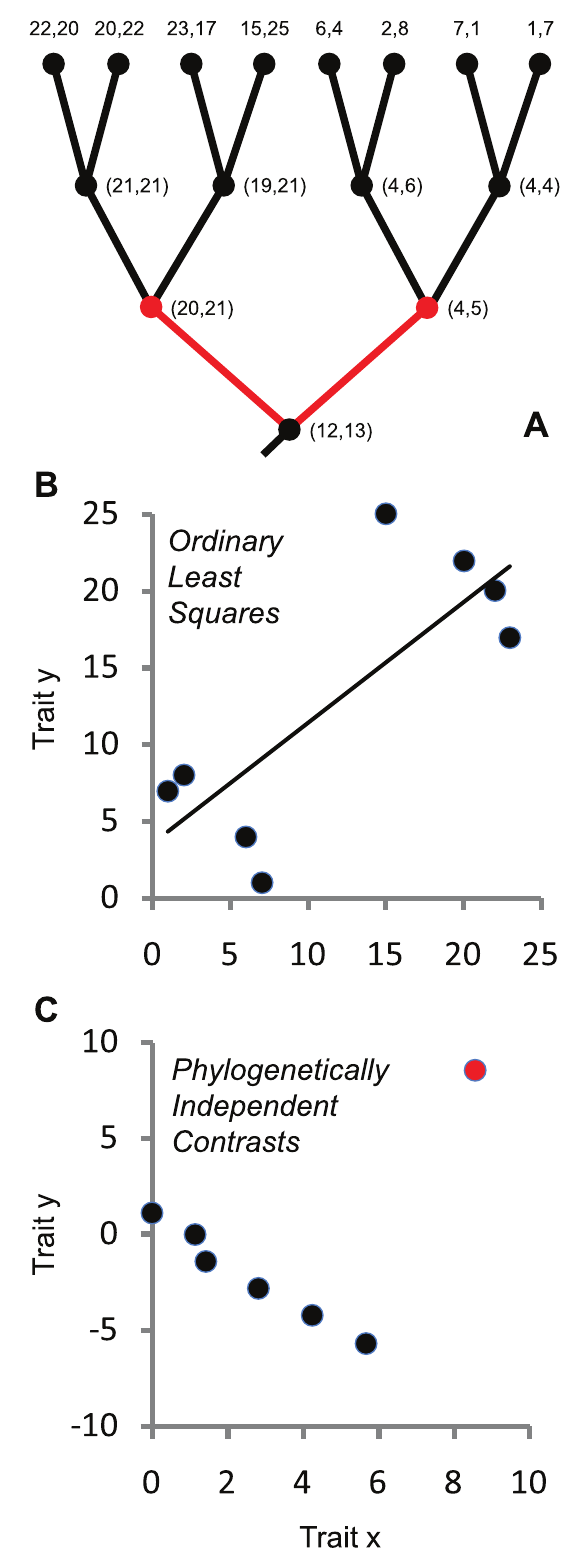
Figure 1. Ignoring phylogenetic history can lead to incorrect conclusions about the nature of evolutionary associations between traits. In this hypothetical example, eight species have been measured for two traits, x and y, as indicated by pairs of values at the tips of the phylogenetic tree (A). Ordinary least-squares linear regression